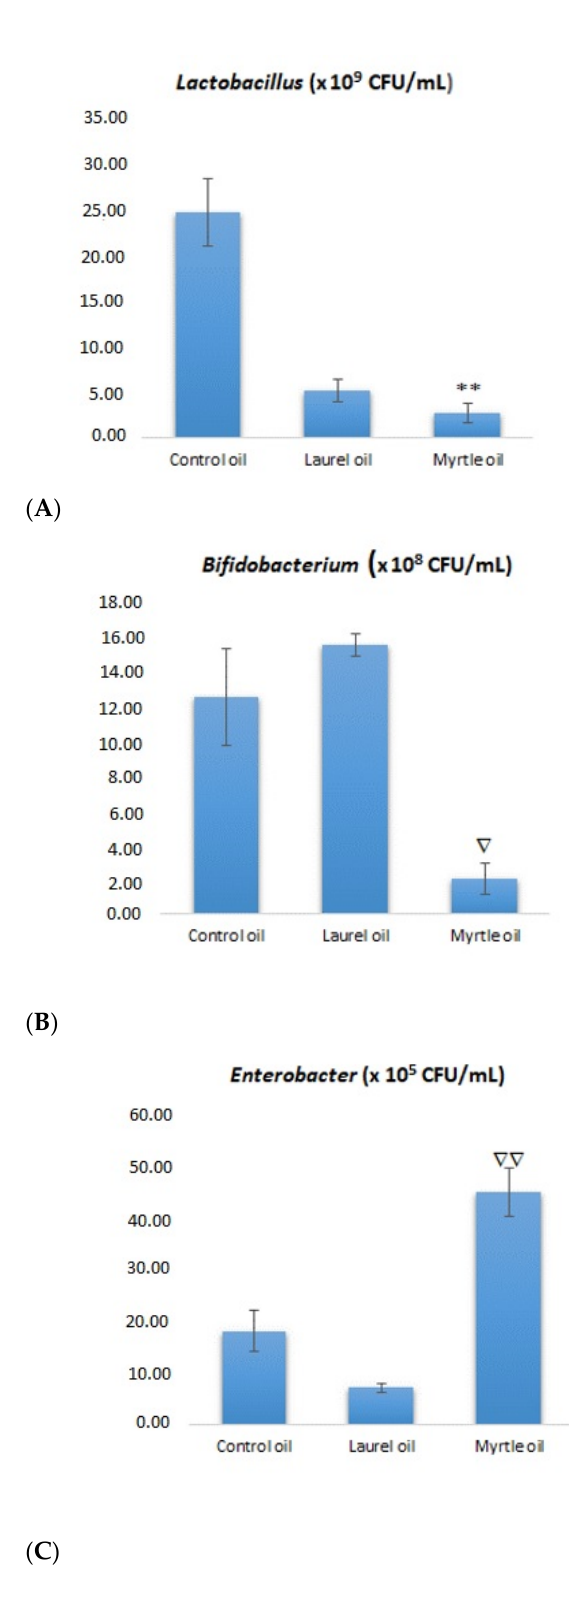
Figure 4. Effect of laurel and myrtle EO application on fecal microbial count of of Lactobacillus ( A ), Bifidobacterium ( B ) and Enterobacteriaceae ( C ). Female rats ( n = 5) were administered ig laurel and myrtle EOs at a dose of 1 μ L per 1 g of rats once daily for 14 days. Laurel and myrtle EOs were mixed with sunflower oil (1:1) and the total daily volume per rat was 0.5 mL. The control group was treated ig with 0.5 mL of sunflower oil. The results are expressed as the mean value of each experimental group ± SEM. * Significantly different in relation to the control group (** p < 0.01); ∇ Significantly different in relation to the laurel-EO-treated group ( ∇ p < 0.05; ∇∇ p < 0.01). Abbreviations: CFU, colony-forming